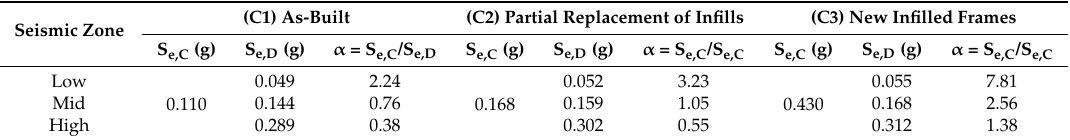
Table 4. Comparison between seismic capacity values and hazard demand relevant to as-built and post-intervention configurations, evaluated for LSLS at different seismic intensity